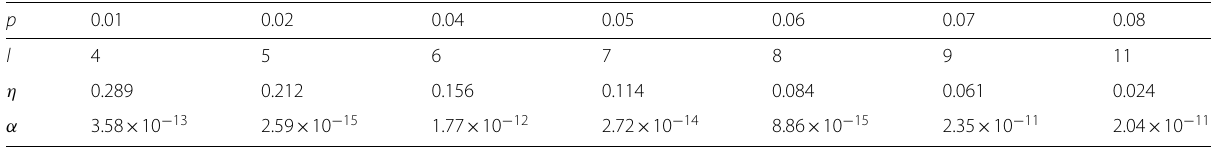
Table 1 Concatenated IR based on [ 15, 11, 3] code